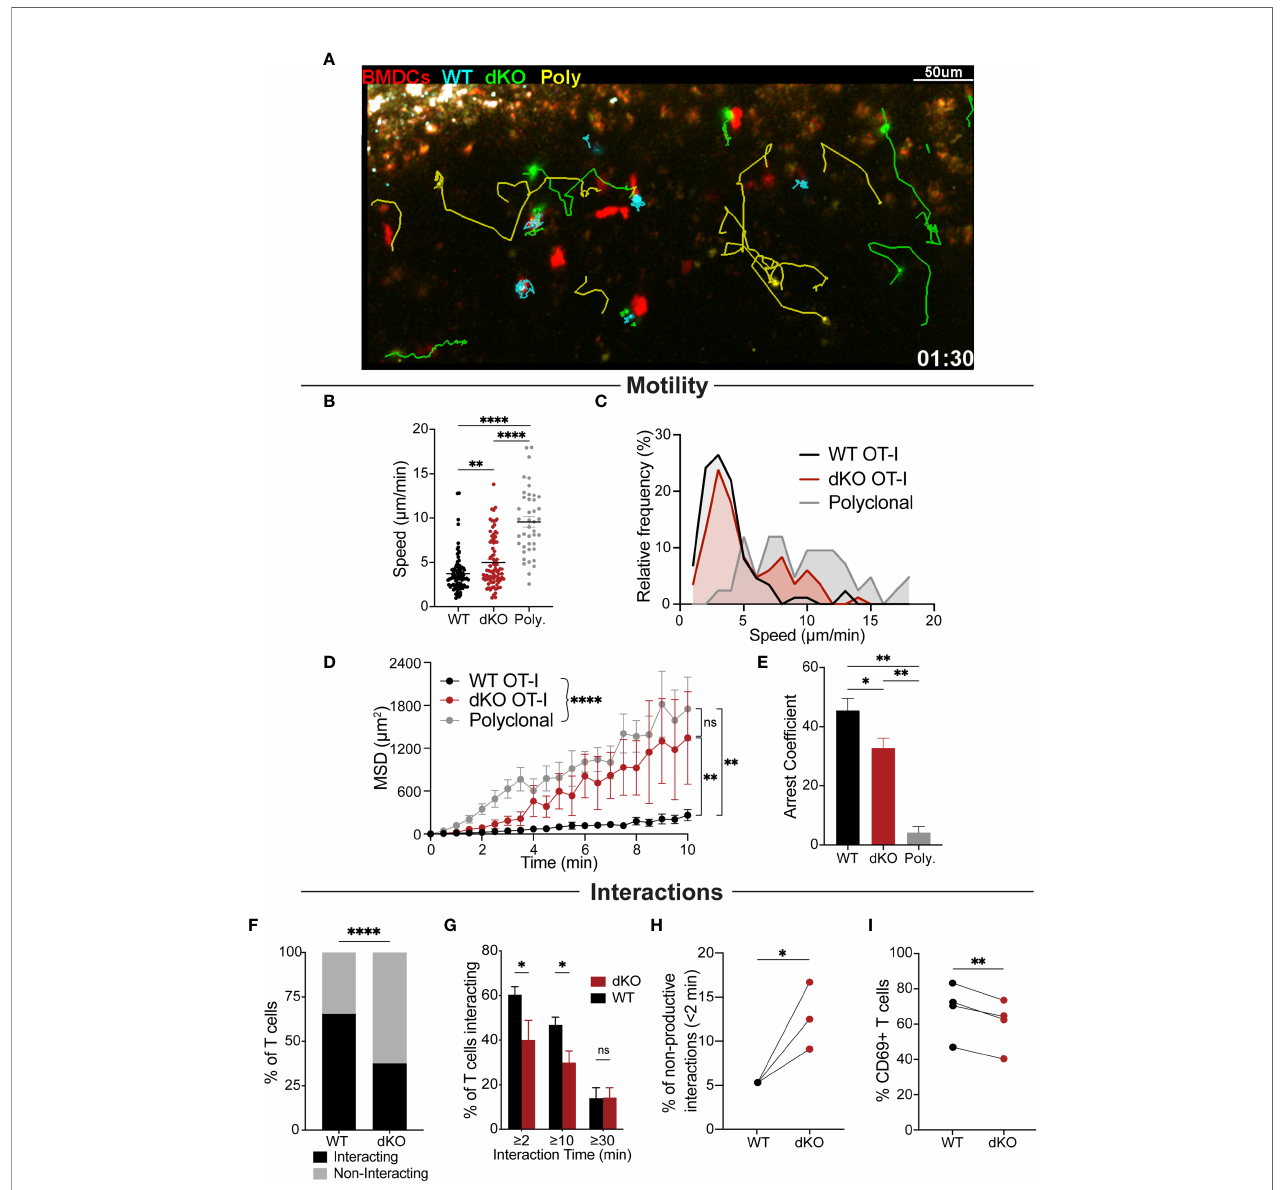
FIGURE 3 | EVL/VASP dKO T cells have impaired APC interactions in vivo . Naïve WT OT-I and EVL/VASP dKO OT-I T cells were isolated from donor mice, differentially dye labeled with CTV or CTFR, and 20,000 of each were co-transferred into WT recipient mice. In a subset of experiments, 200,000 polyclonal WT T cells dye labelled with CFSE were also co-transferred with the OT-I T cells. 24 hours later, OVA-pulsed tdTomato-BMDCs were injected subcutaneously into recipient mice. After 13 – 19 hours, mice were euthanized and the draining popliteal LNs were harvested and analyzed by time-lapse two-photon microscopy. T cells were tracked and their interactions with BMDCs were also quanti fi ed. (A) Representative snapshot from a movie depicting the movement of EVL/VASP dKO OT-I T cells (green), WT OT-I T cells (cyan), polyclonal control T cells (yellow), and BMDCs (red). Track lines show the path of T cell movement imaged over 30 minutes. Scale bar, 50 µm. (B) Mean velocities of WT OT-I, EVL/VASP dKO OT-I, and polyclonal control T cells in the presence of antigen-pulsed BMDCs. Each dot represents a single T cell. (C) Frequency distribution of T cell speed. (D) Mean square displacement (MSD, +/-SEM) over time of WT OT-I, EVL/VASP dKO OT-I, and polyclonal control T cells. (E) Average arrest coef fi cient (percentage of time that a T cell ’ s instantaneous velocity <2 m m/min) of WT OT-I, EVL/ VASP dKO OT-I, and polyclonal control T cells. Mean +/- SEM. (F) Total number of WT and EVL/VASP dKO OT-I T cells interacting (for at least 2 minutes) and non-interacting with APCs. n=130 WT cells and 128 EVL/VASP dKO cells. (G) Distribution of T cell – APC interaction times shown by graphing percent of WT and EVL/VASP dKO OT-I T cells interacting with BMDCs for given durations. (H) Quanti fi cation of non-productive T cell – APC interactions: graph of percent of interactions that occurred in which T cells disengaged from APCs within 2 minutes. (I) Quanti fi cation of CD69 expression in T cells from the LNs of the imaging experiments. Immediately following two-photon microscopy, imaged LNs were digested and analyzed by fl ow cytometry. Data in (B – G) are from ≥ 5 experiments each with ≥ 2 mice per group, data in (H) are from 3 experiments, as experiments with <20 cells were excluded, and data in (I) are from 4 experiments. Signi fi cance was assessed by 1-way ANOVA (B, E) , 2-way ANOVA (D, G) , paired t test (H, I) , and Fisher ’ s exact test (F) ; ns is not signi fi cant, * is p < 0.05, ** is p < 0.01, and **** is p <